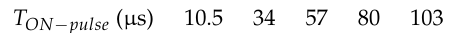
Figure 18. Excitation analysis of the sensor for different values of input pulse width. The width of the input pulse is swept in a range of [1, 120 µ s] ( a ) maximum amplitude second oscillation curve. Each point of this curve is obtained by recording the first positive peak of the oscillation generated by the falling edge of the input pulse; ( b ) example of how to build the curve in ( a ) with a pulse width of T ON − pulse = 60 µ s. L m = 50 mH, R b = 300 Ω , C s = 300 pF, C E = 2 nF, C C 1 = 1 nF, C C 2 = 22 nF. Table 2. Local maximum for the curve in Figure